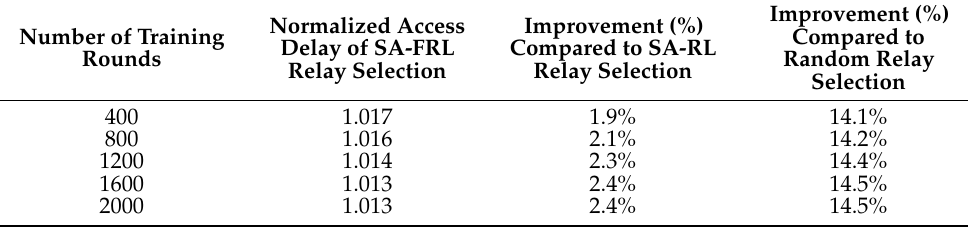
Table 4. Normalized access delay of SA-FRL with different amount of pre-training data, simulated